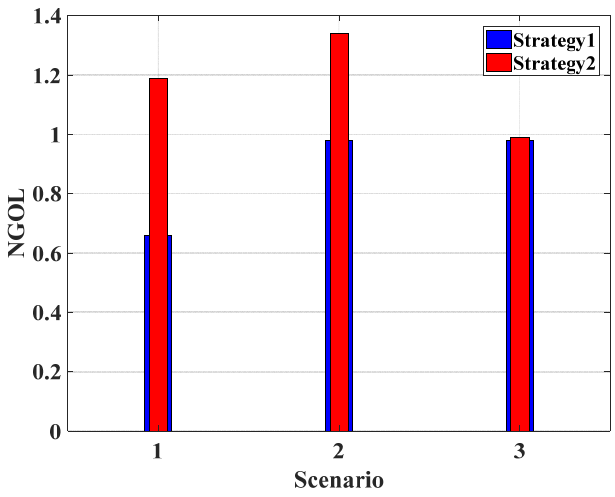
Figure 9. The comparative result of the NLOI indices.